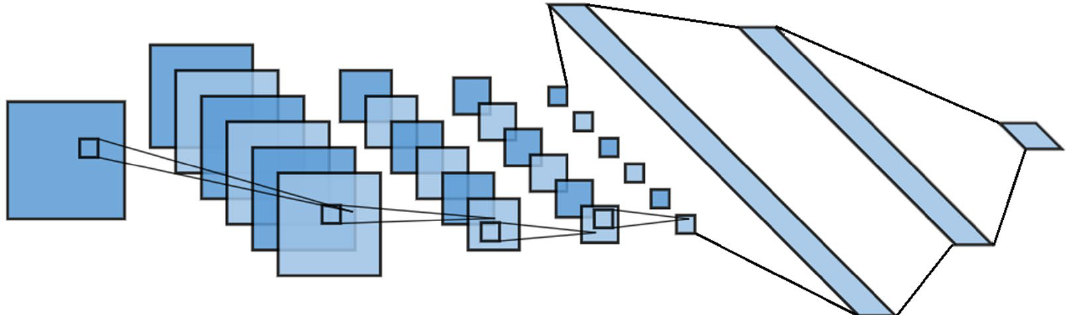
Figure 2. Typical CNN network: LeNet-5.